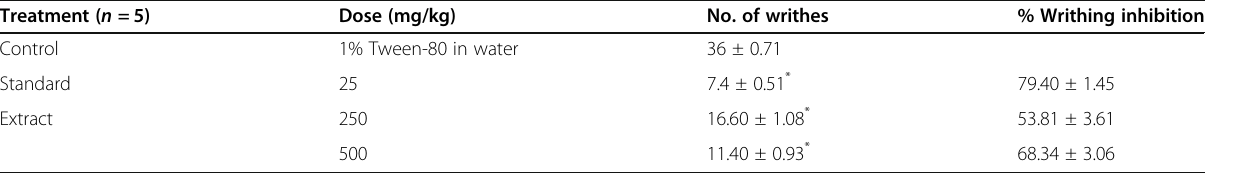
Table 2 Effect of ethanolic extract of M. umbellata on acetic acid-induced writhing in mice Treatment ( n = 5)